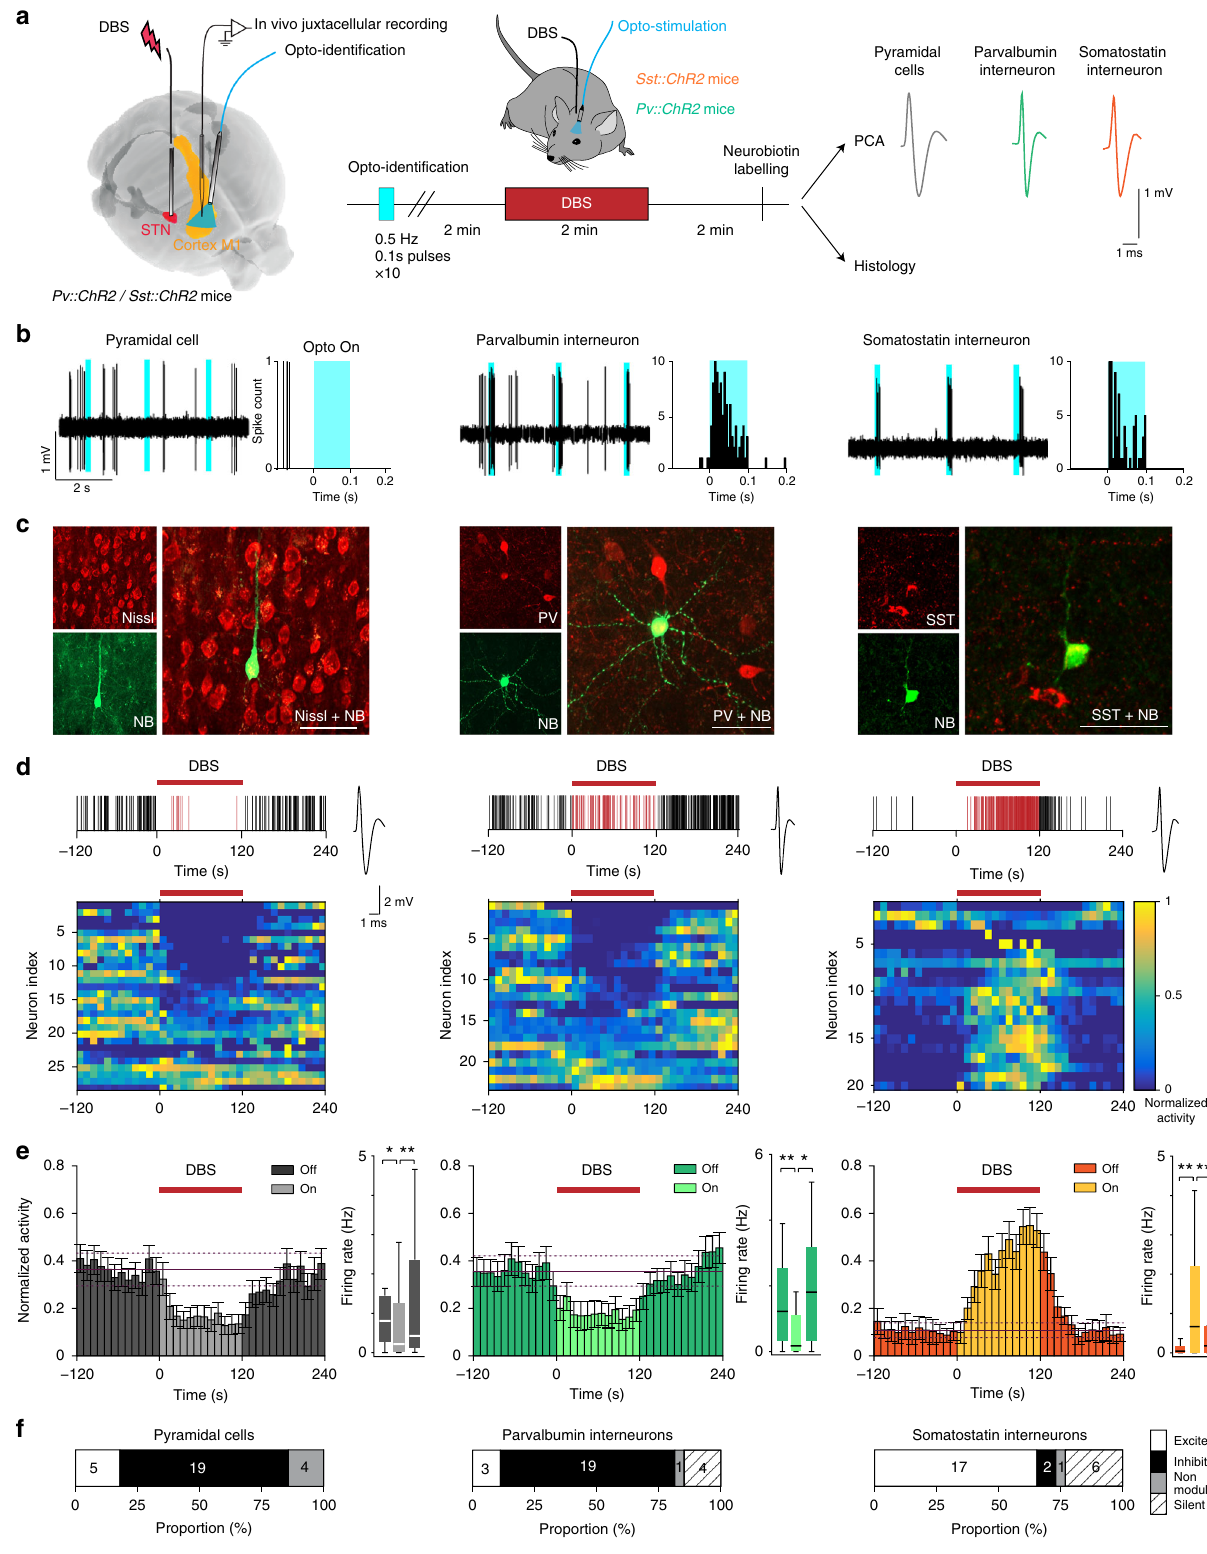
M1 L5 model recapitulates DBS effects on cortical fi ring . To better understand the bene fi cial effects of DBS and SST opto- activation, we theoretically tested the information processing capabilities of cortical networks in control and parkinsonian conditions under DBS and when activating PV or SST